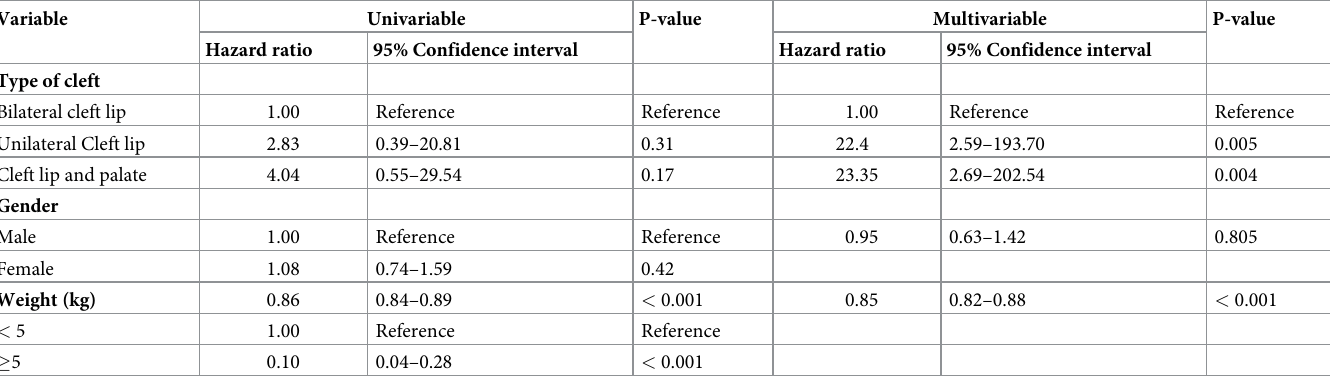
Table 5. Cox proportional regression of the hazard of late primary repair among babies with cleft lip and palate.